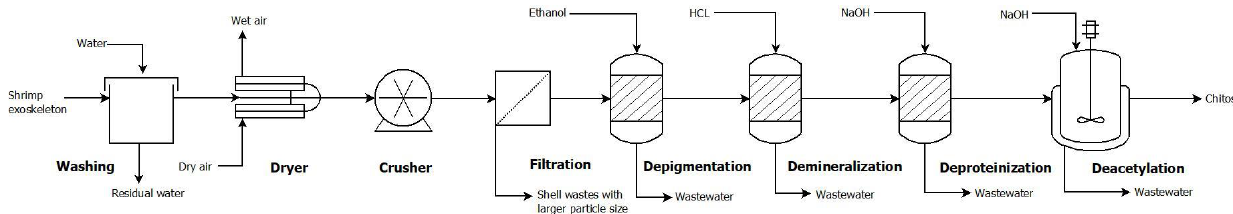
Figure 5. Process diagram of chitosan production from shrimp shell